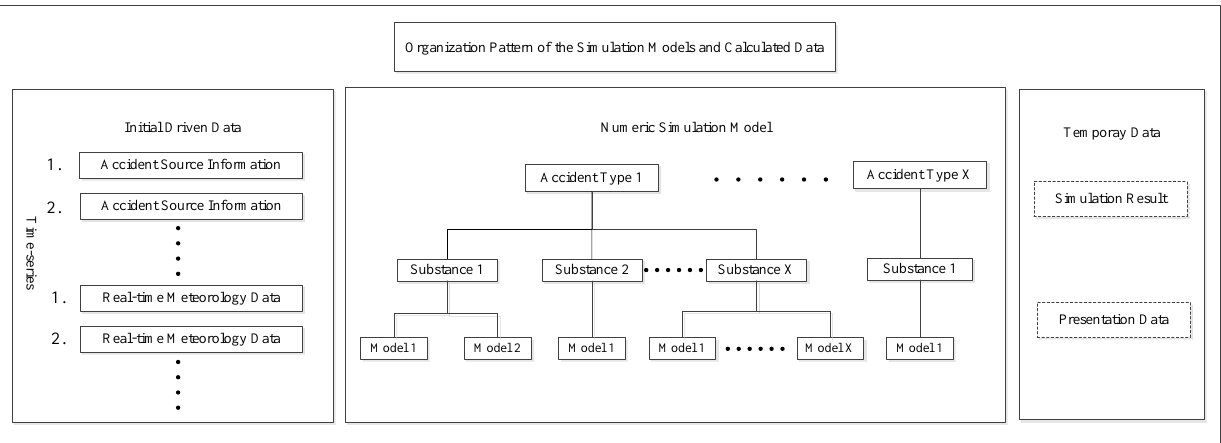
Figure 1. Conceptual design framework of the organization pattern of the simulation models and calculated